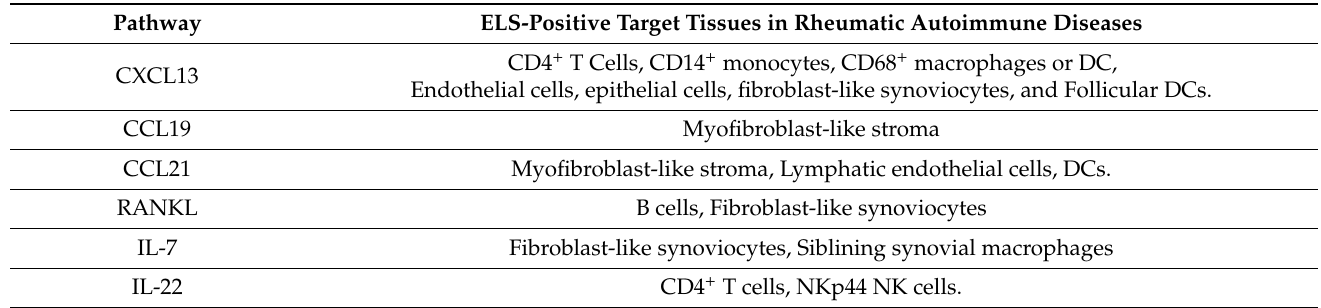
Table 1. Cellular sources of the chemokines regulating ectopic lymphoid organogenesis. ELS-Positive Target Tissues in Rheumatic Autoimmune